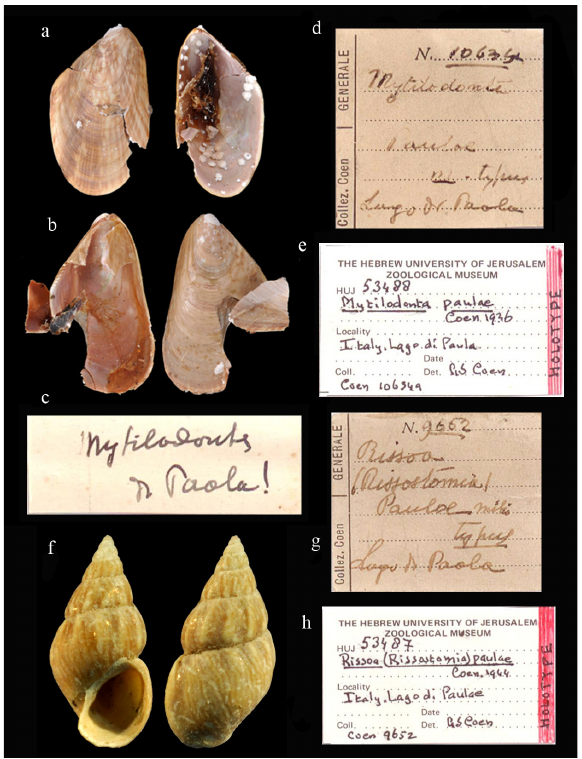
Fig. 2. Taxa described with Sabaudia Lake as type locality (not to scale, sizes reported as maximum height × maximum width) and corresponding labels. A-E. Mytilodonta Coen, 1936 and Mytilo- donta paulae Coen, 1936. A, Holotype (Coen 10634a - HUJ53488) - 7.39 × 5.22 mm; B, Paratype (Coen 10634b - HUJ53489) - 8.72 mm; C-D, Coen’s original handwritten labels; E, Holotype label; F-H, Rissoa paulae Coen in Brunelli and Cannicci, 1940; F, Holo- type (Coen 9652 - HUJ53487) - 5.09 × 2.42 mm; G, Coen’s original handwritten label; H. Holotype